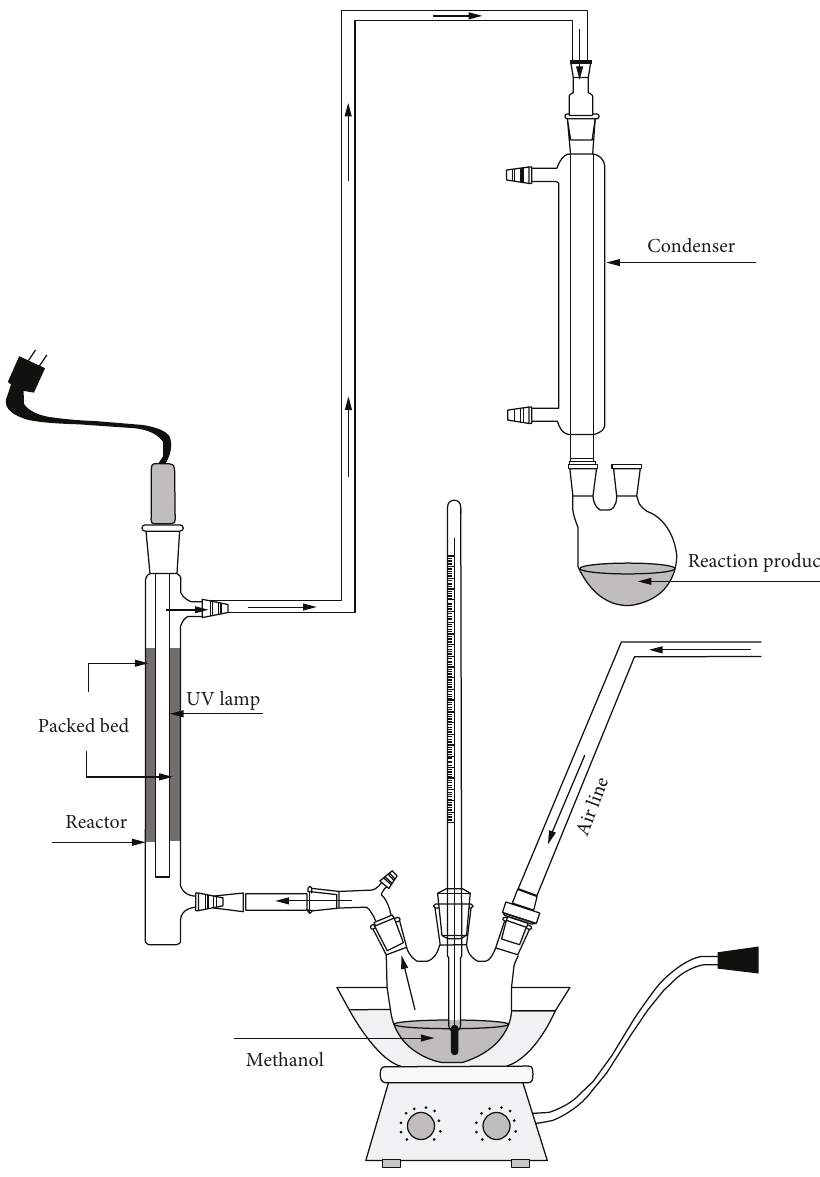
Figure 1: Bench-scale photocatalytic reactor